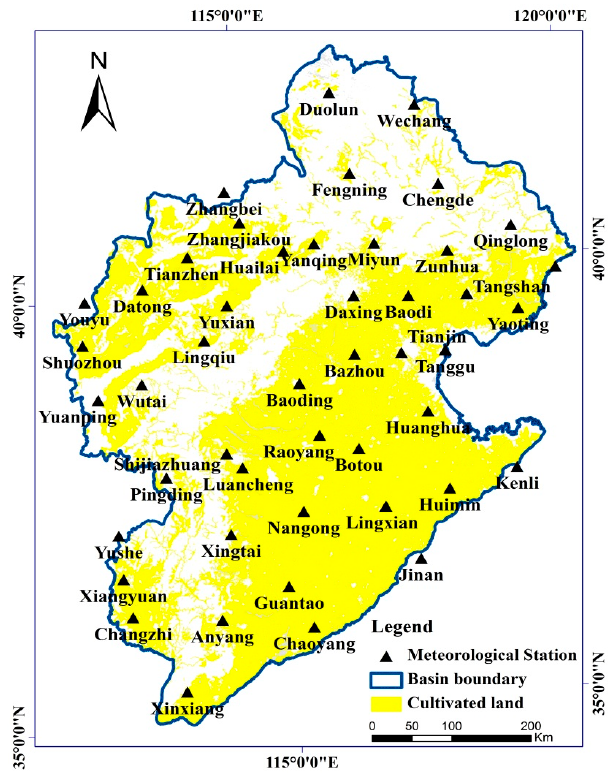
Figure 2. The distribution of meteorological stations in the Haihe River Basin.